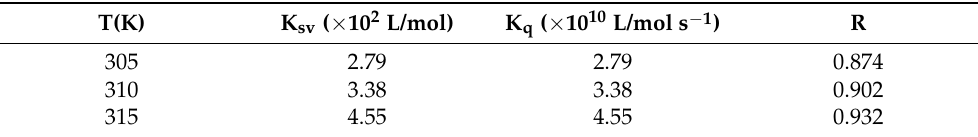
Figure 8. The unmodified Stern–Volmer curves of MAO-B fluorescence quenched by LB. Table 5. The quenching constant (K sv ) and correlation coefficient of MAO-B.